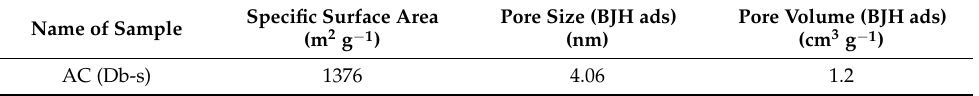
Table 4. Brunauer–Emmett–Teller (BET) specific surface area, pore size and pore volume of AC (Db-s).